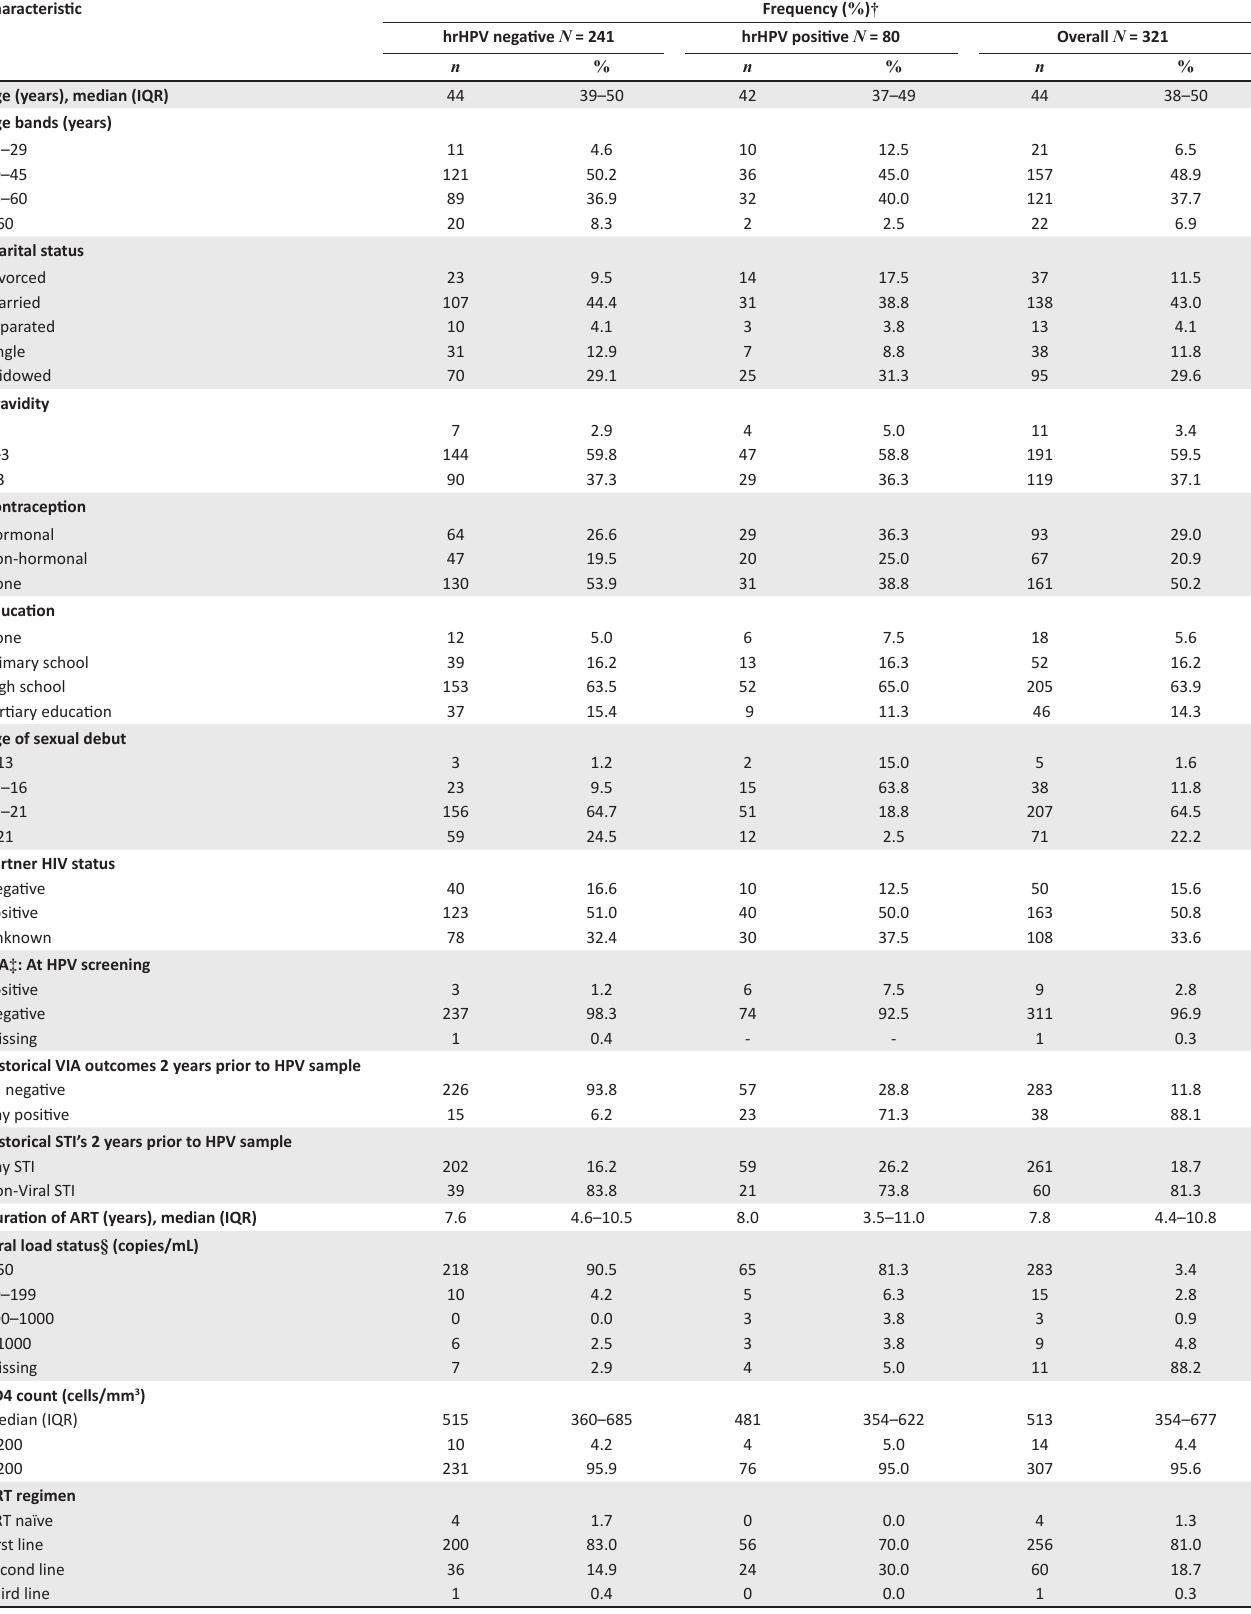
TABLE 1: Socio-demographic characteristics and risk factors of participants at baseline ( N = 321).